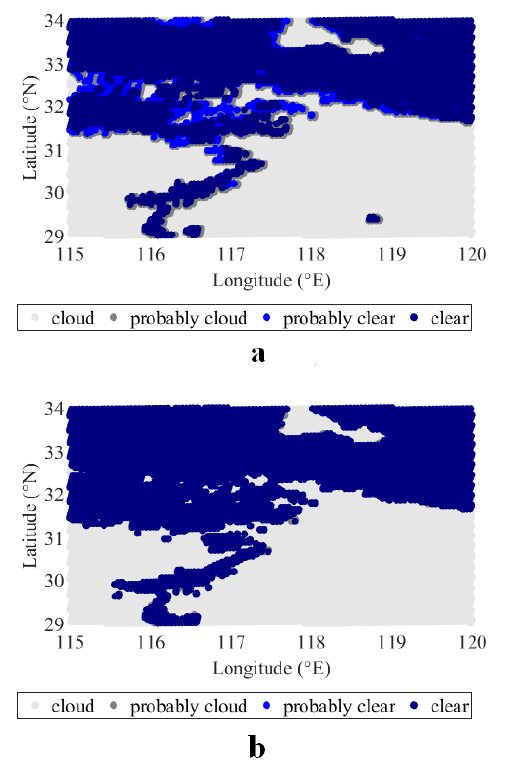
Figure 10. Cloud detection image at UTC 20181119070000. Figure a is the CLM product of FY-4A, and Figure b is the detection result of the decision tree cloud detection model.